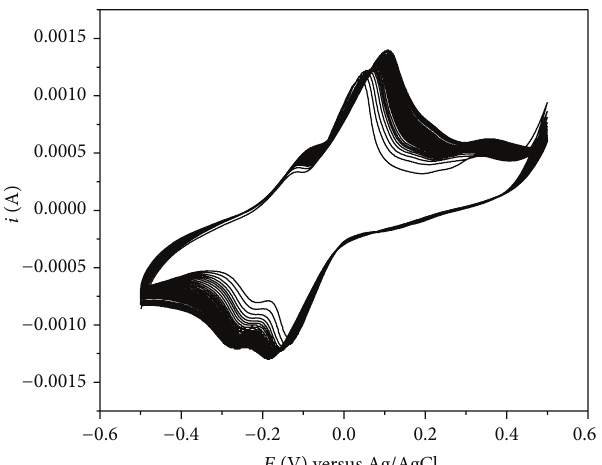
Figure 1: Cyclic voltammograms (40 cycles) during electropolymerization of aniline on graphite in 0.5 M H 2 SO 4 solution containing 0.1M aniline at a scan rate of 50 mVs −1 at room